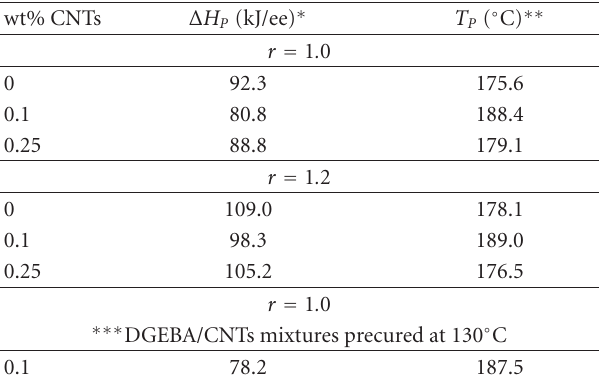
Table 1: Summary of the dynamic DSC results.